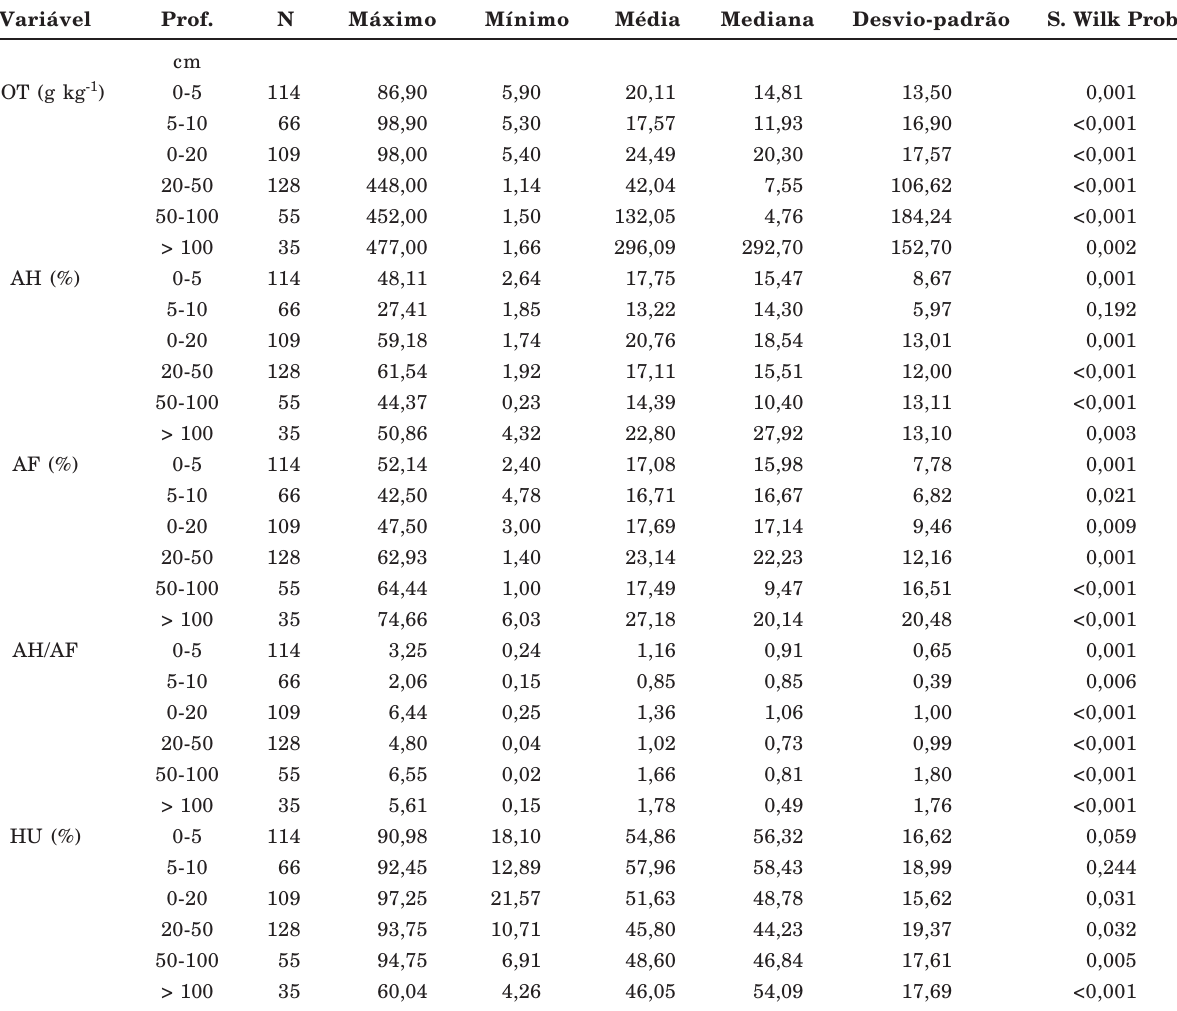
Quadro 2. Estatística descritiva das variáveis analisadas: carbono orgânico total (COT), ácidos